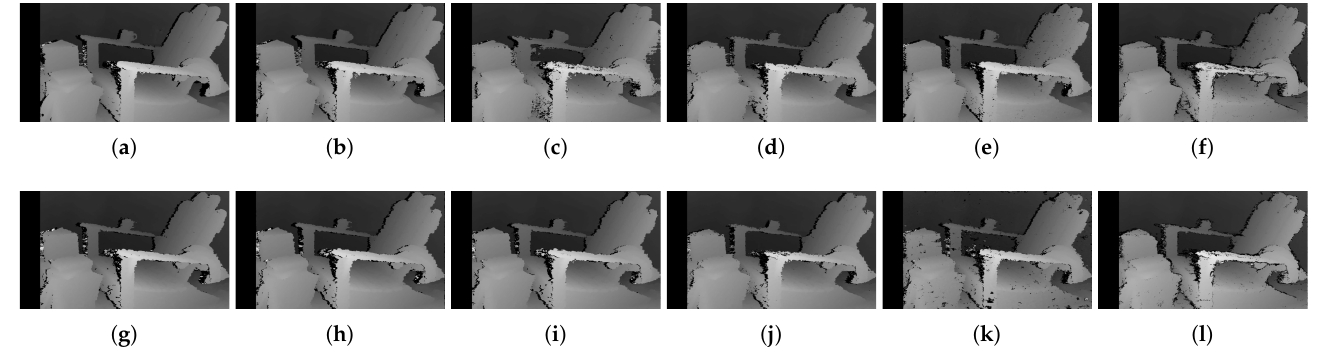
Figure 15. Estimated disparity images of the combinations of cost and image filter using the SGM stereo method, according to the low and high pattern contrast parameters. The images in the top row show disparities at low contrast, and the images in the bottom row show those at high contrast, respectively. ( a ) SGM, AD. ( b ) SGM, Mean/AD. ( c ) SGM, LoG/AD. ( d ) SGM, BilSub/AD. ( e ) SGM, Rank/AD. ( f ) SGM, Census. ( g ) SGM, AD. ( h ) SGM, Mean/AD. ( i ) SGM, LoG/AD. ( j ) SGM, BilSub/AD. ( k ) SGM, Rank/AD. ( l ) SGM, Census.